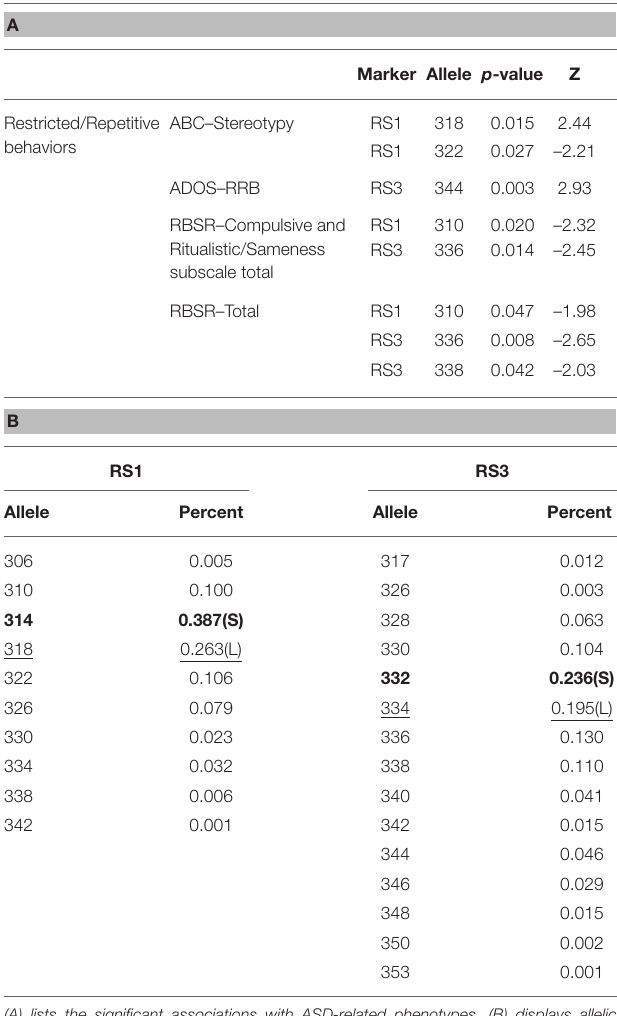
TABLE 4 | FBAT analysis for AVPR1A microsatellites and allelic